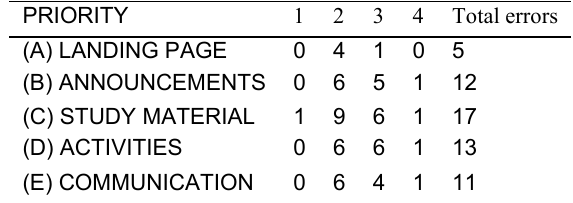
Table 2. Number of usability errors by section for